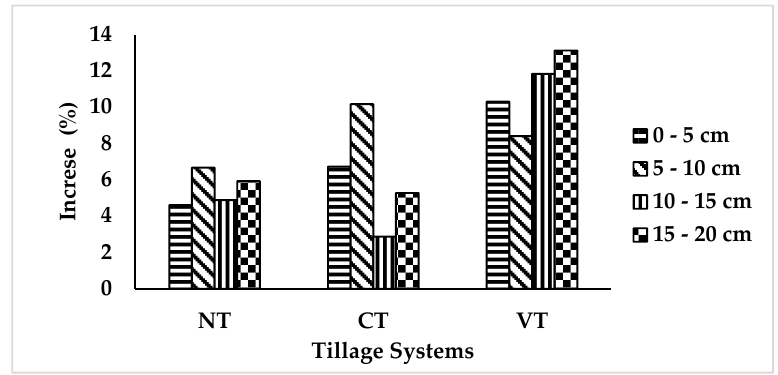
Figure 3. Change of bulk density in 2015 compared to 2013.